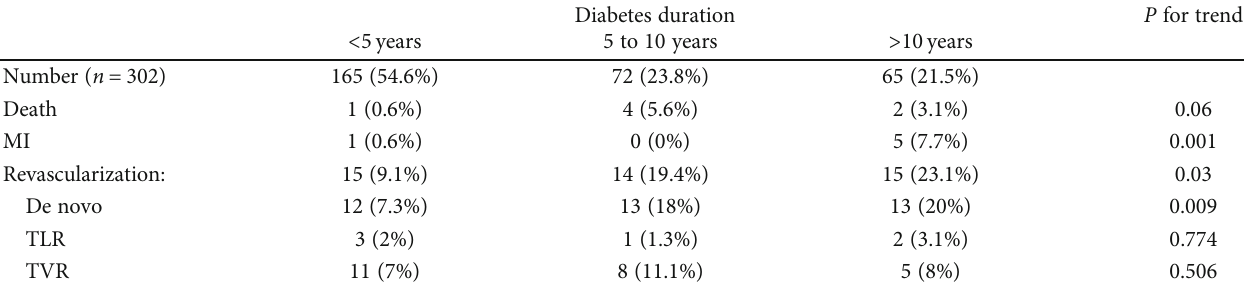
Table 3: Relationship between diabetes duration and MACEs.